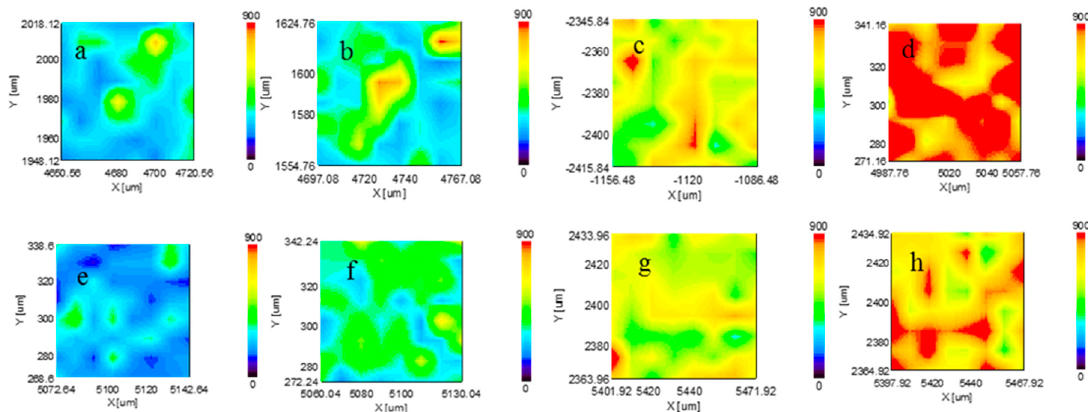
Figure 8. Raman mapping images for MoS 2 -butyl rubber with different concentrations of MoS 2 with either ethanethiol or nonanethiol: ( a ) 0.5 phr, ethanethiol; ( b ) 1 phr, ethanethiol; ( c ) 3 phr, ethanethiol;